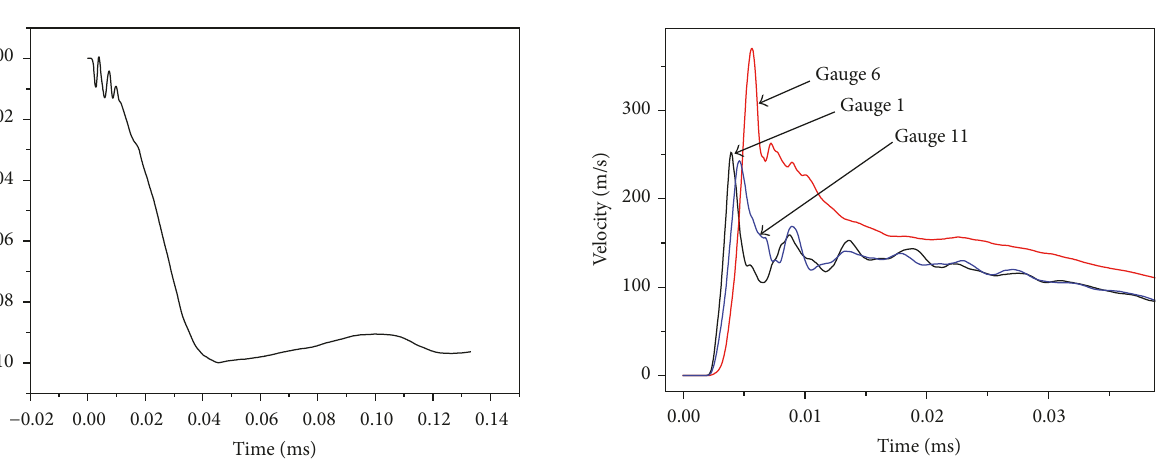
Figure 15: Strain of Gauge 15 on the exterior surface. Figure 16: Velocity of inner